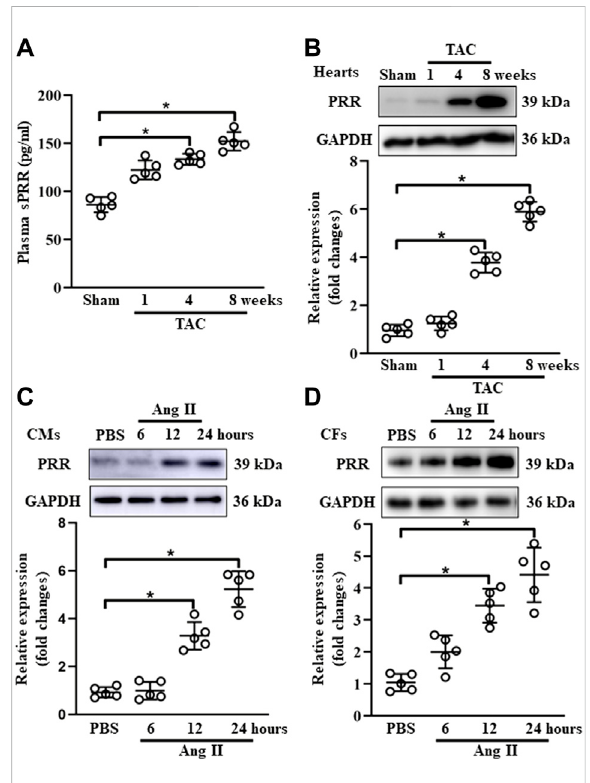
FIGURE 1 PRR expression is positively associated with cardiac remodeling. (A) The plasma concentration of soluble PRR in mice after 1, 4 and 8 weeks of transversus aortic constriction (TAC). (B) Immunoblot analysis of PRR in mouse failing hearts and quantitative analysis of the PRR protein level normalized to GAPDH. (C) Immunoblot analysis of PRR in Ang II-induced cardiomyocytes (CMs) and quantitative analysis of the PRR protein levelnormalizedtoGAPDH. (D) ImmunoblotanalysisofPRRinAng II-induced cardiac fi broblasts (CFs) and quantitative analysis of the PRRproteinlevelnormalizedtoGAPDH. p p -value < 0.05. n =5per group. Data are expressed as mean ±